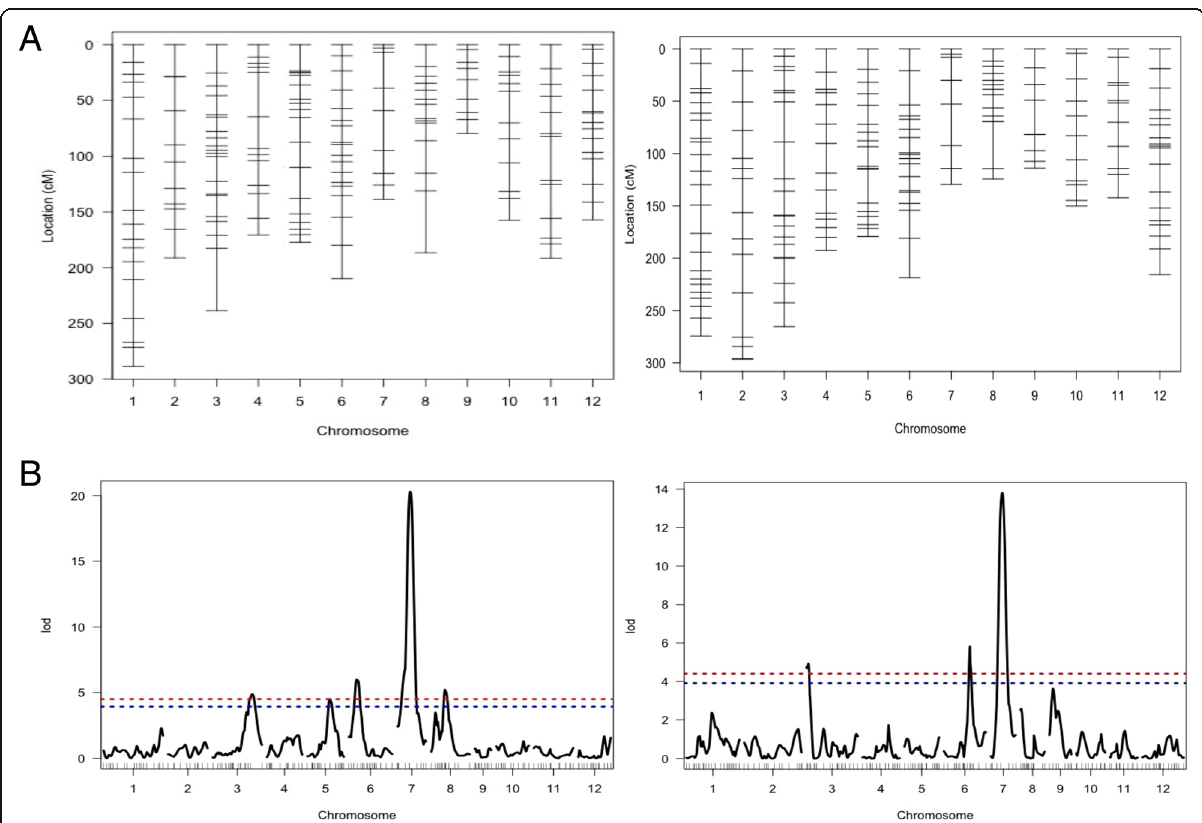
Fig. 3 a Genetic map of Kalarata/NSIC Rc238 population (left side) and Kalarata/NSIC Rc222 population (right side) showing marker and QTL positions. b Whole-genome scan plots obtained by interval mapping for SUR at 21 DAS in screenhouse conditions for Kalarata/NSIC Rc238 population (left side), and Kalarata/NSIC Rc222 population (right side). Horizontal lines indicate the significant logarithm of odds threshold at 5% and 1% confidence levels (from the bottom to the top) based on 10,000